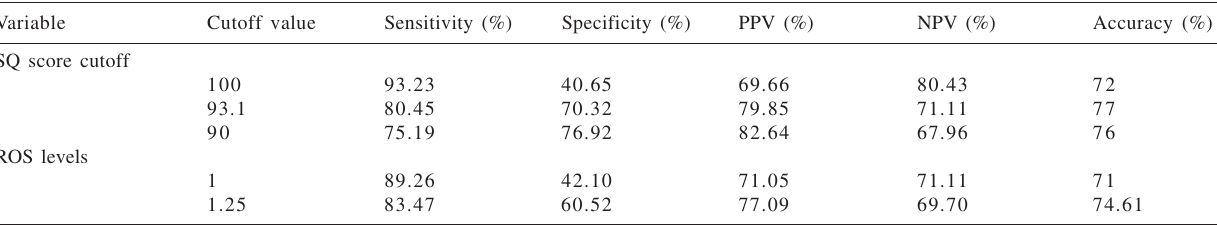
Table 2 - Identification of male factor infertility patients using prediction parameters with different cutoff values